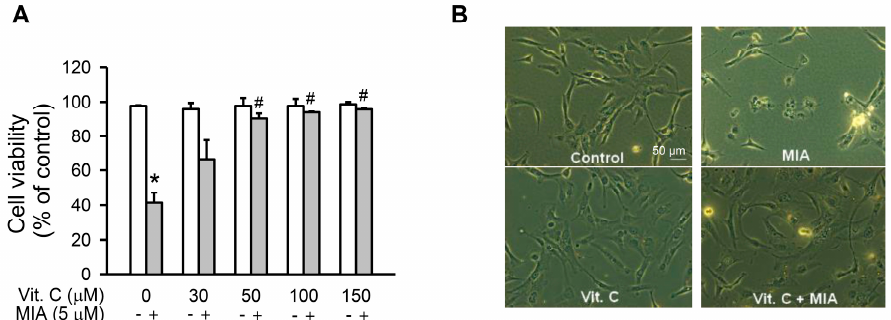
Figure 1. Effect of vitamin C on cell viability in Monosodium iodoacetate (MIA)-treated SW1353 cells. The SW1353 cells were incubated with 30–150 μ M vitamin C in the presence or absence of 5 μ M MIA for 24 h. ( A ) viable cells were counted by trypan blue exclusion and expressed as a percentage of the control; and ( B ) the morphology of cells with or without 100 μ M vitamin C in the presence or absence of 5 μ M MIA was observed under a phase-contrast microscopy at 200× magnification. The data are the mean ± S.D. for three separate experiments, each in triplicate. * p < 0.05 compared to the untreated control. # p < 0.05 compared to the MIA treated group.